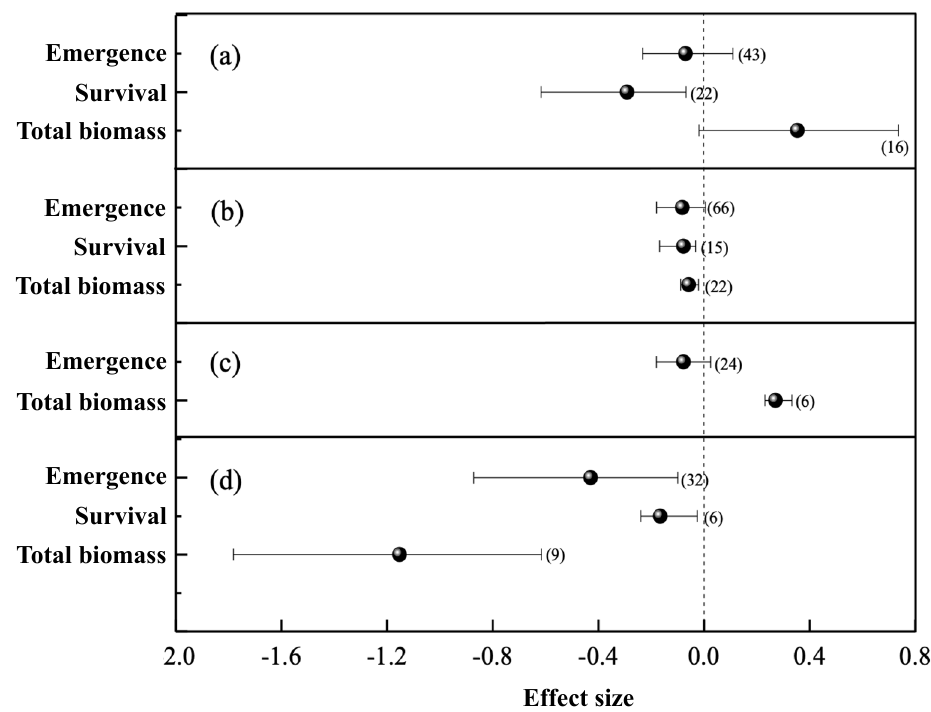
Figure 8. Mean effect size of litter cover for seedling emergence, survival, and total biomass in field ( a ), greenhouse ( b ), common garden ( c ), and germination chamber ( d ) studies. Error bars represent 95% CIs. The numbers in brackets represent the sample size of each indicator.